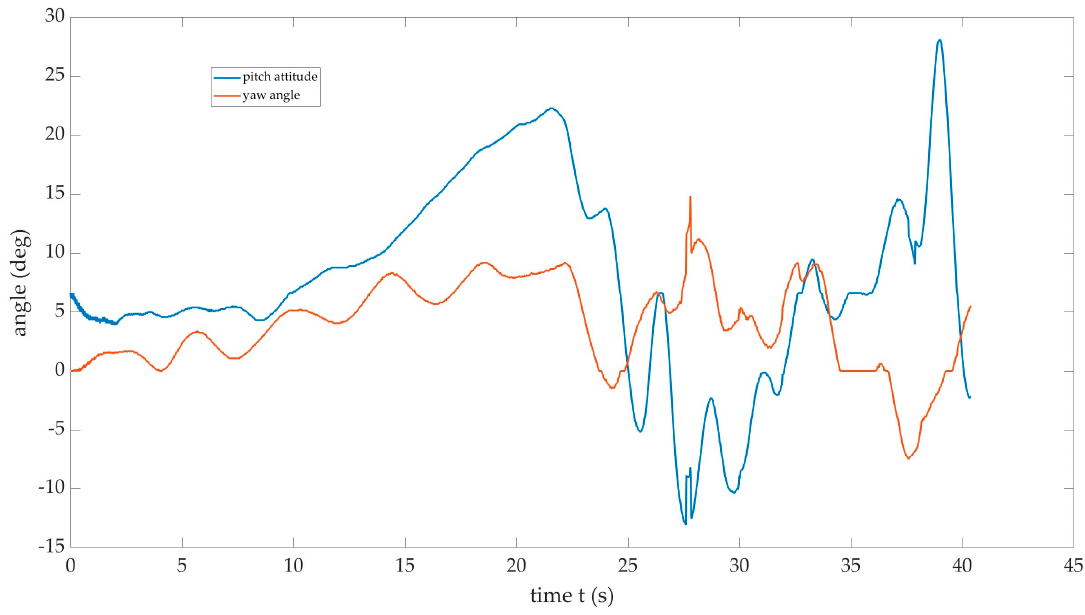
Figure 7. Time series pitch attitude data from GoPro rear view image sequence.